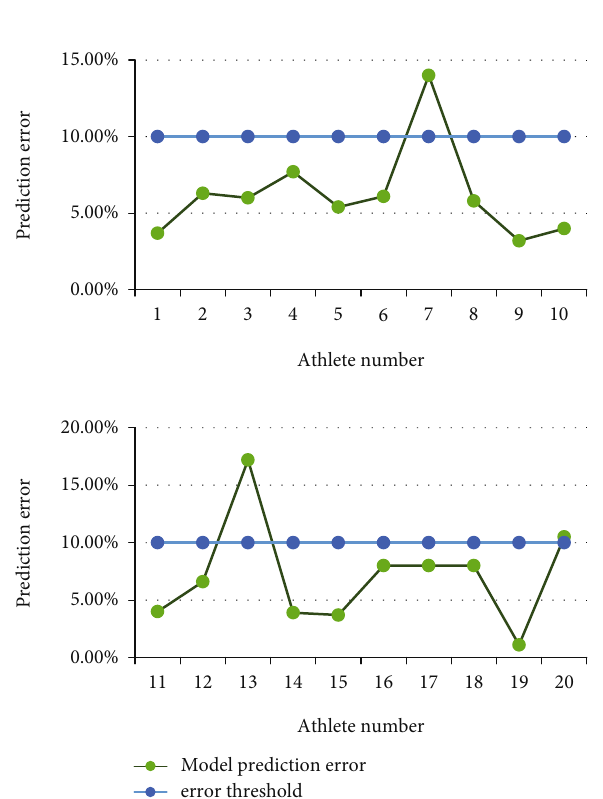
Figure 6: Prediction error of the health assessment